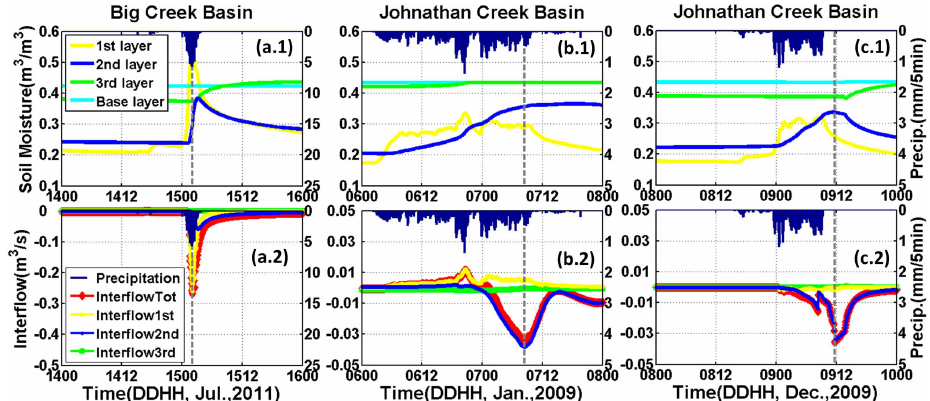
Fig. 9. The time series of soil moisture (top) and interflow (bottom) produced at each soil layer at the pixel in which debris flow occurred. The x axis is zoomed into the rainfall period to show details more clear. The dash lines indicate the time when the magnitude of total interflow reaches its